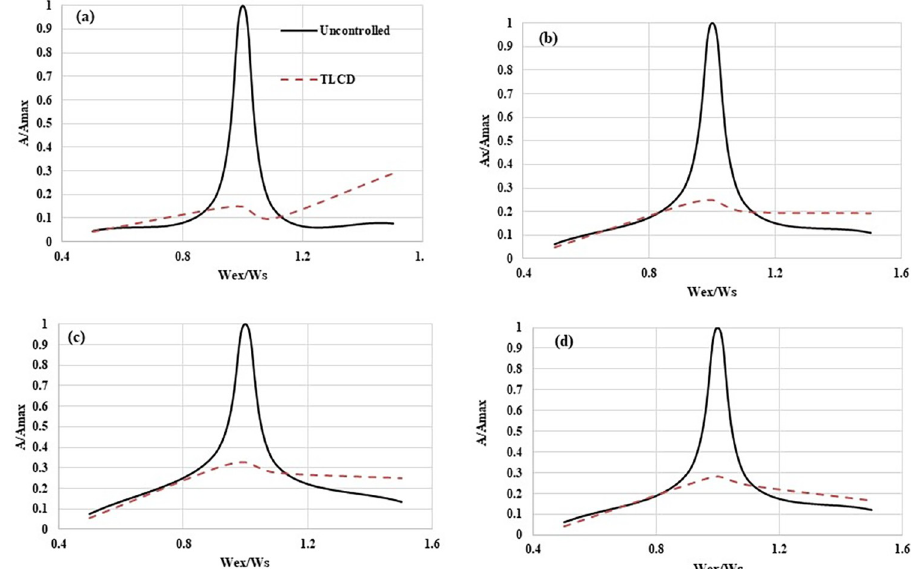
Fig 6. Normalized RMS acceleration responses of the MDOF structure equipped with and without TLCD, (a) Storey Level -01, (b) Storey Level -02, (c) Storey Level -03, (d) Storey Level